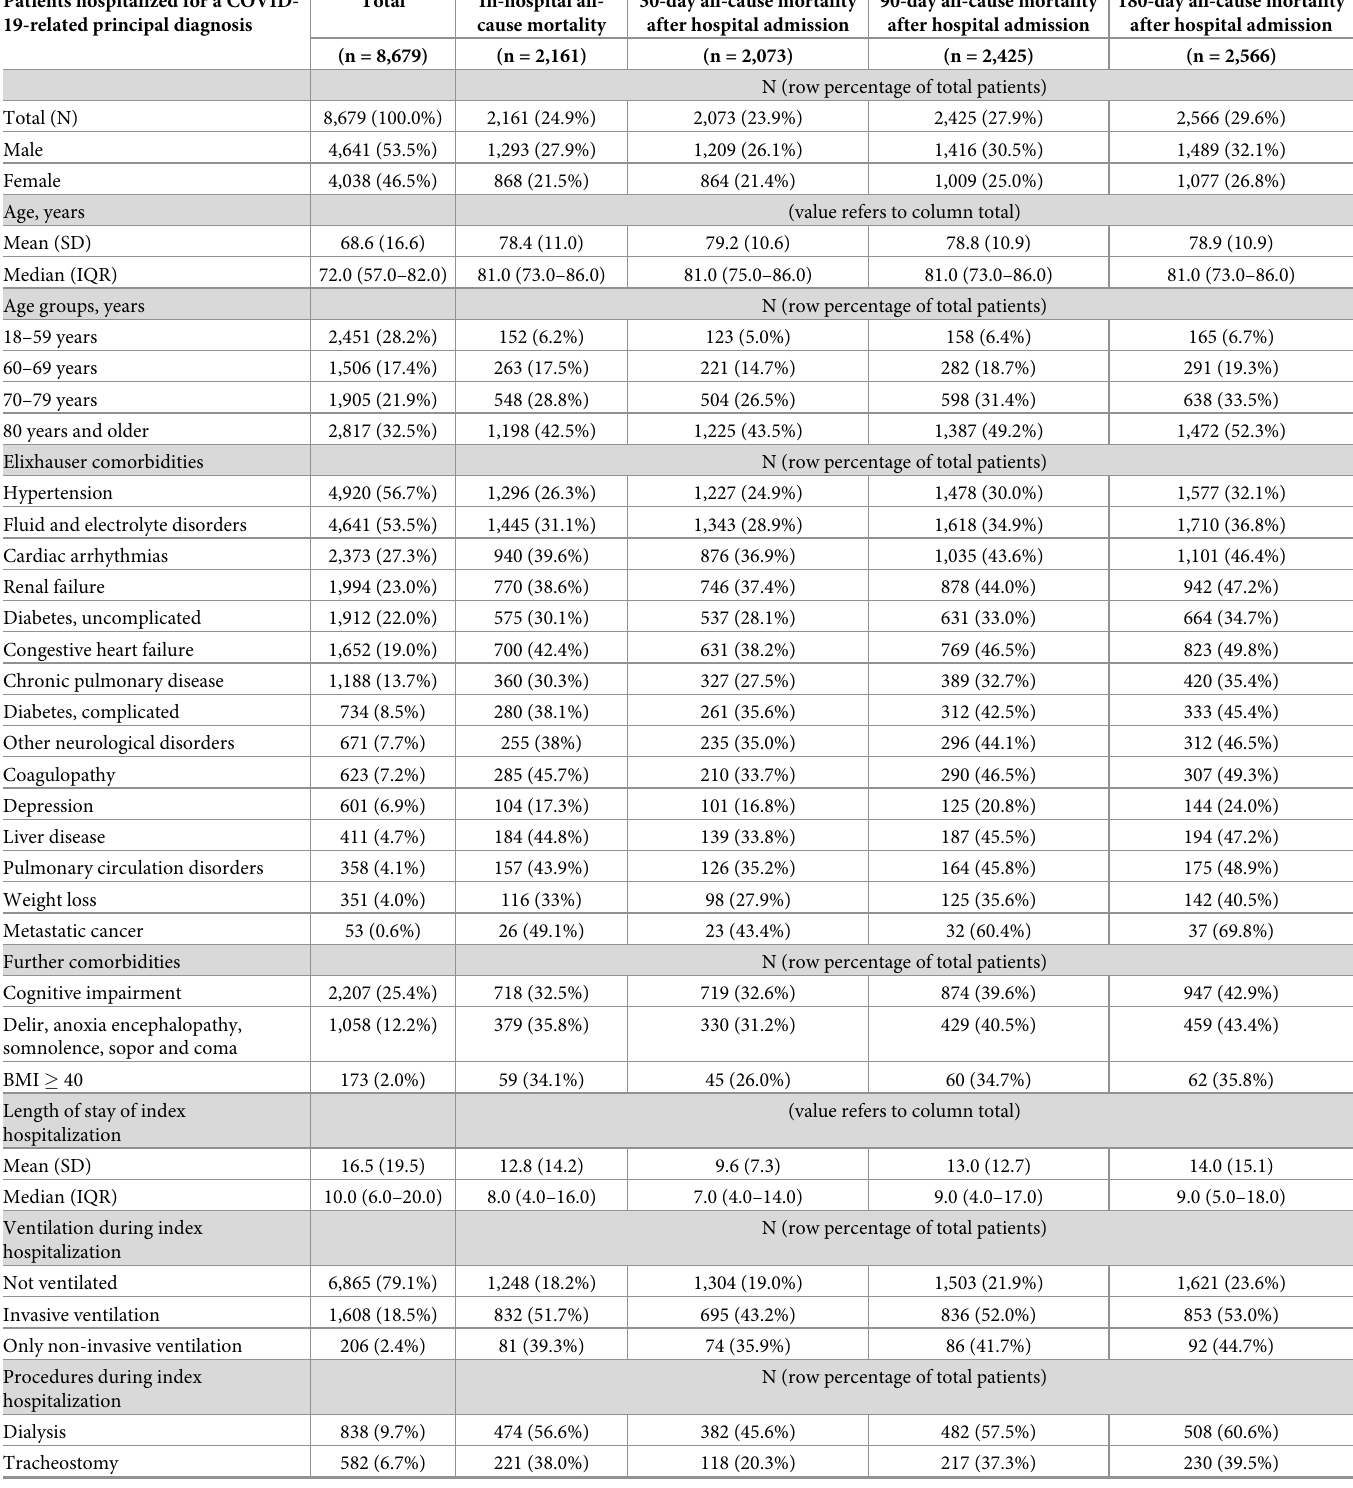
Table 1. Patient characteristics and all-cause mortality. Patients hospitalized for a COVID- 19-related principal